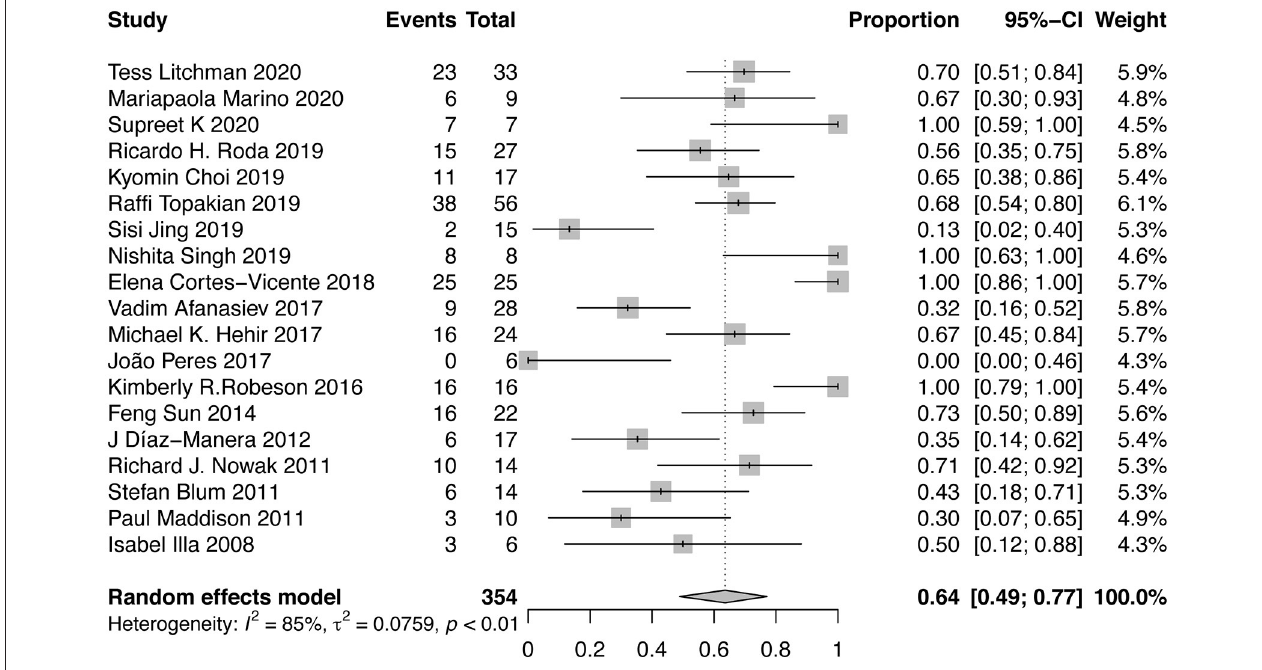
FIGURE 2 | Forest plot showing the mean effect size and 95% CI for the proportion of patients achieving MMS or better.